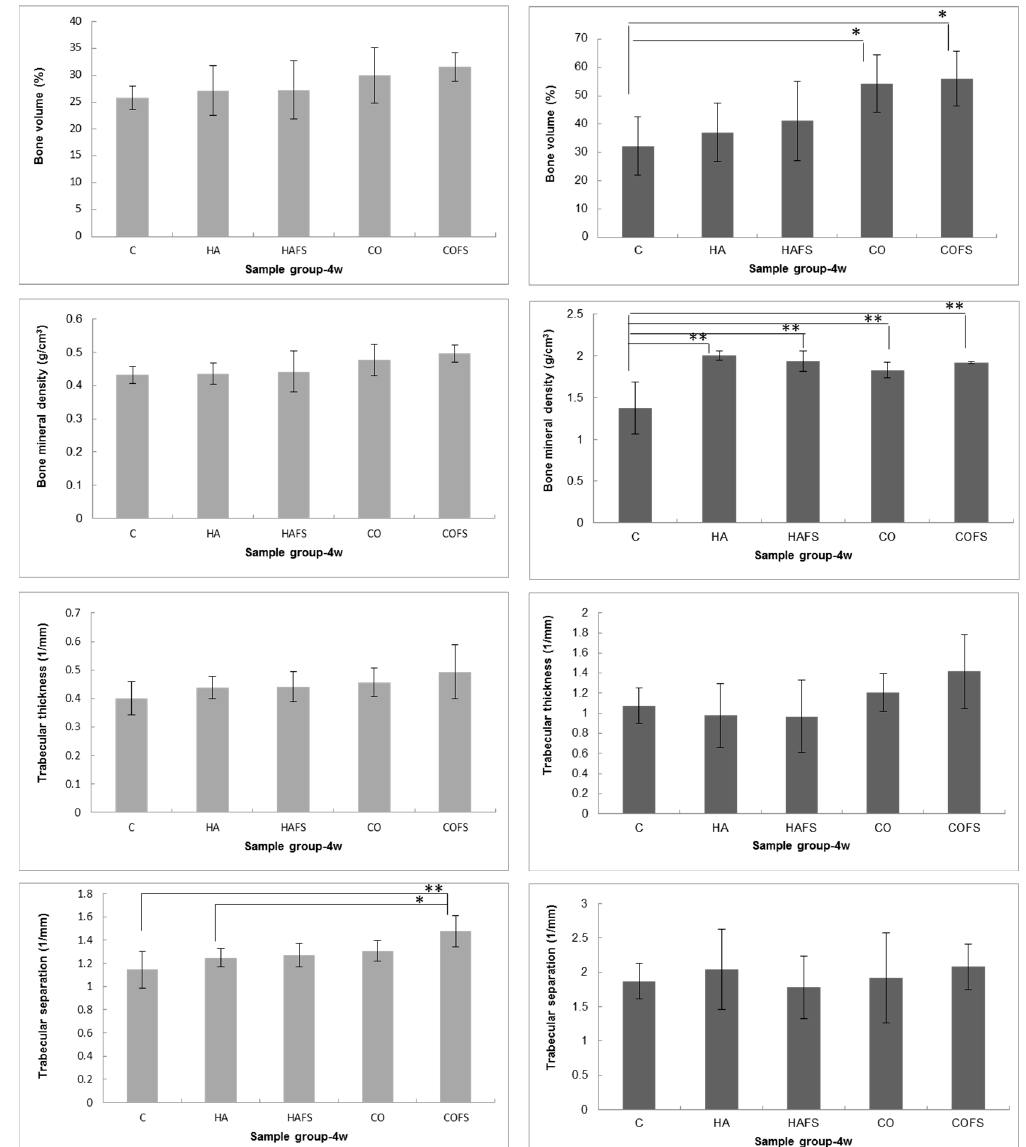
Figure 6. Micro-CT analysis of lower right incisor extraction sockets in vertical (left columns) and horizontal (right columns) planes at two and four weeks: bone volume, bone mineral density, trabecular thickness, and trabecular separation. A p value of <0.05 (*) and a p value of <0.01 (**) were considered significant.